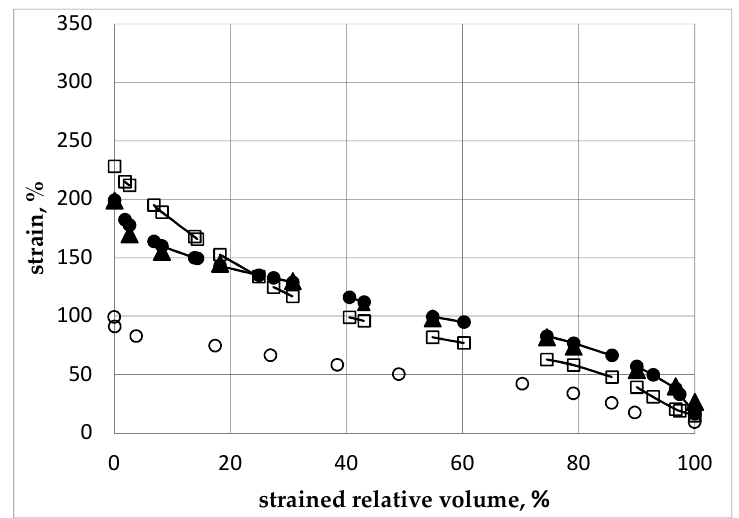
Figure 5. Strain level (%) versus the strained relative volume of sample (%) after different ECAP processes—open circles ( O ): after a 1st pass, open squares ( □ ): after a 2nd pass, billet is not rotated reference to the 1st pass, black circles ( ● ): after a 2nd pass, with a rotation of φ = 90° reference to the 1st pass, black triangles ( ▲ ): after a 2nd pass, with a rotation of φ = 180°.